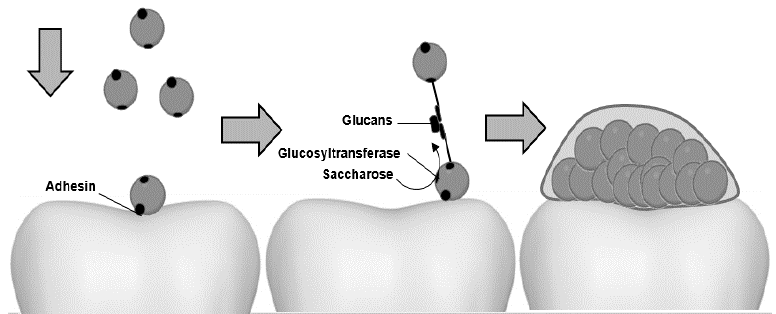
Figure 2. Adhesion and biofilm formation of S. mutans to dental surfaces. The invasion of planktonic cells to the teeth is carried out through membrane adhesins, and they use sucrose to promote cell-cell union and synthesize the extracellular polymeric matrix on dental enamel.